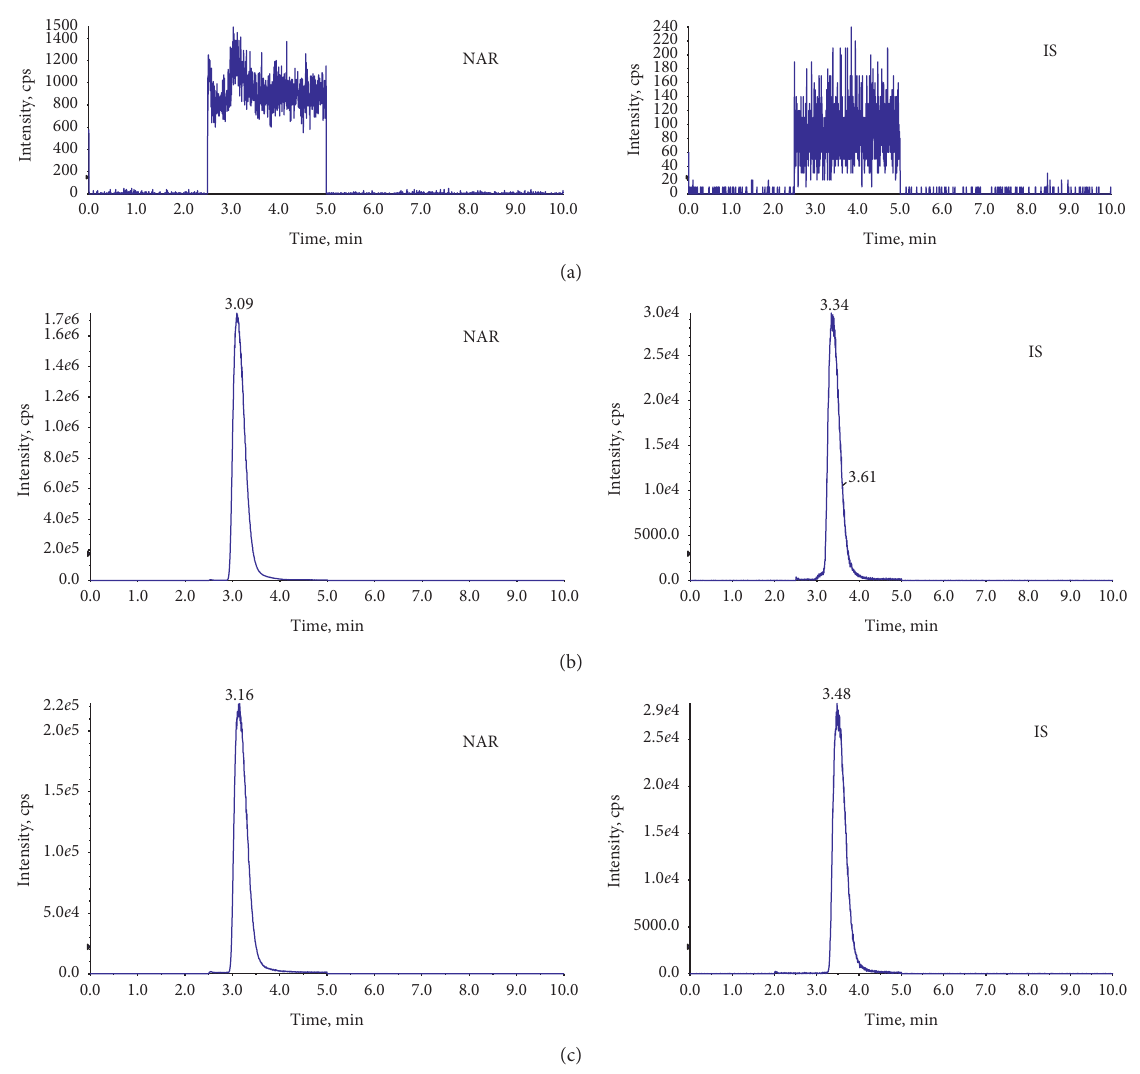
Figure 6: The chromatograms of MRM: (a) blank plasma, (b) plasma mixed with NAR, and (c) plasma after oral administration of